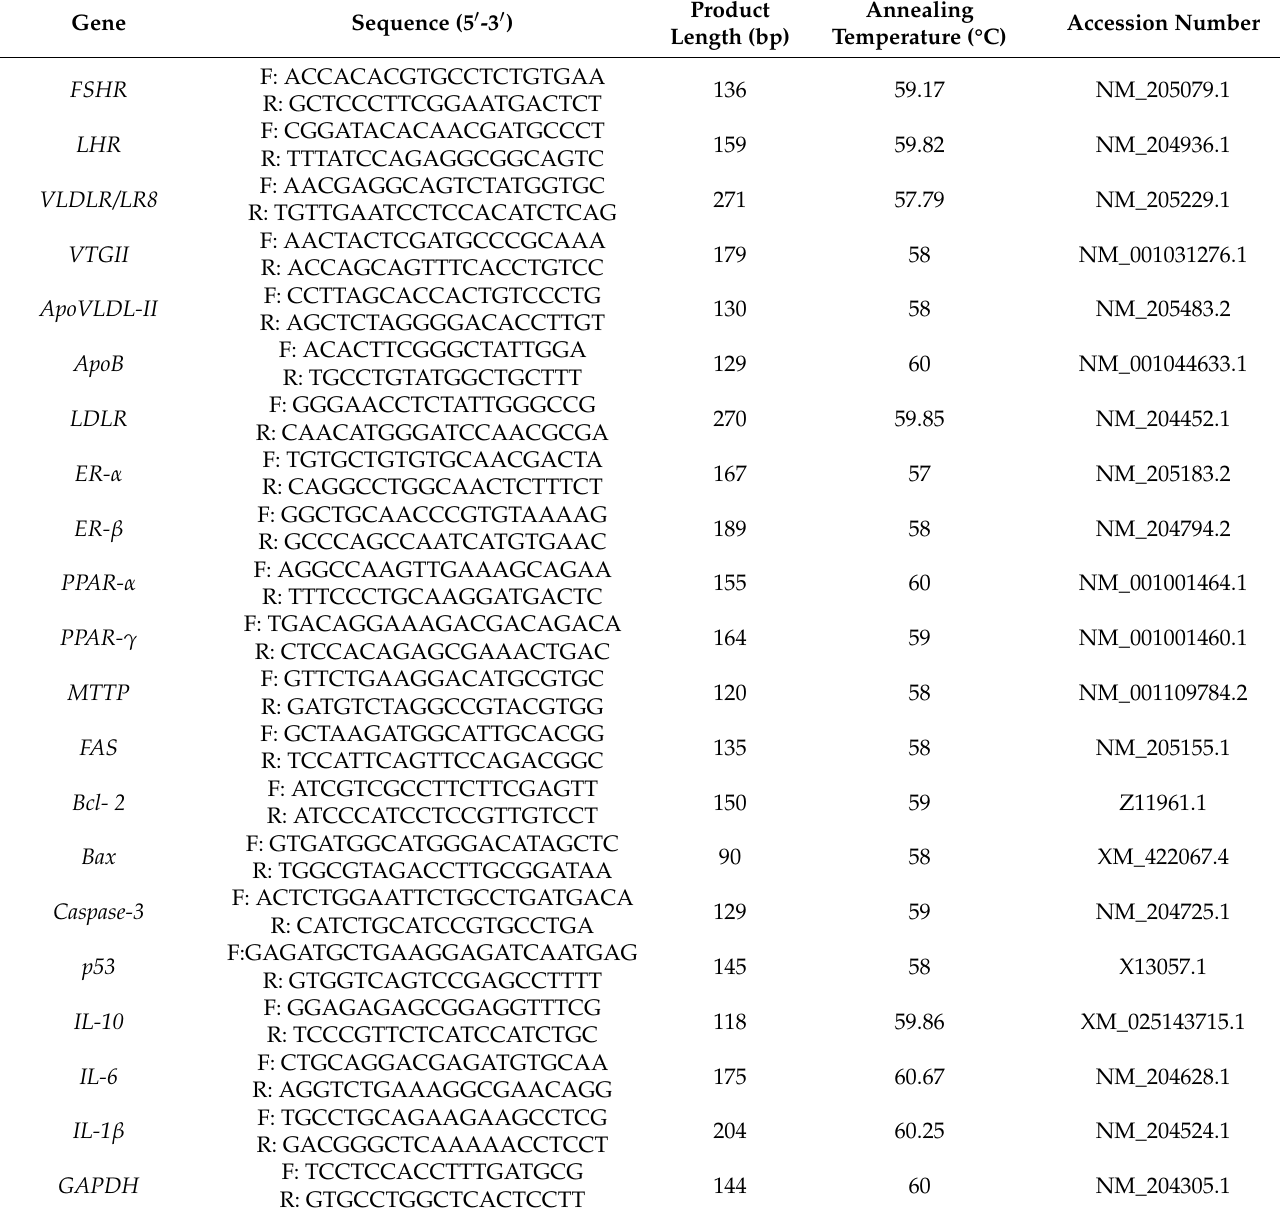
Table 2. Primers used for quantitative real-time polymerase chain reaction